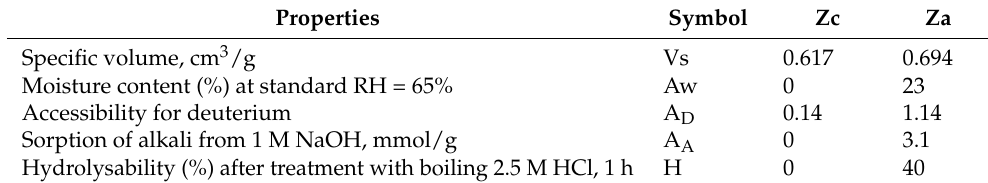
Table 4. Some properties of crystalline and amorphous cellulose [2,3].